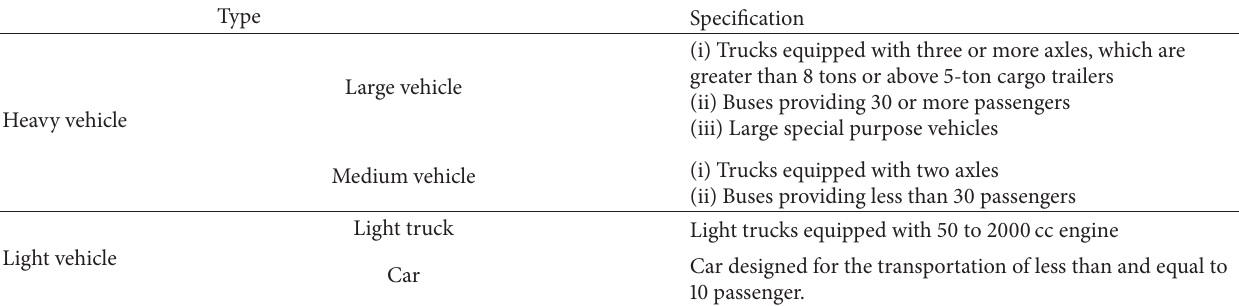
Table 1: Vehicle types used in this study.